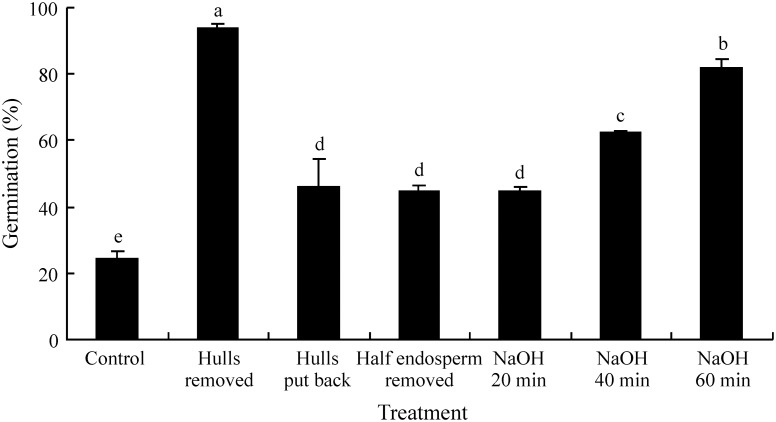
Effect of hulls, half-endosperm removal and NaOH scarification on germination of fresh seeds of Stipa bungeana at 20°C in dark.Different letters indicate significant difference (P<0.05) among all treatments (n = 4).